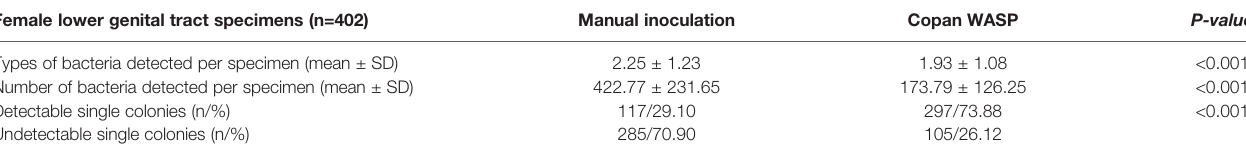
TABLE 1 | The types of bacteria, number of colonies and comparison of the detection rate of single colonies detected using manual and automated inoculation methods.